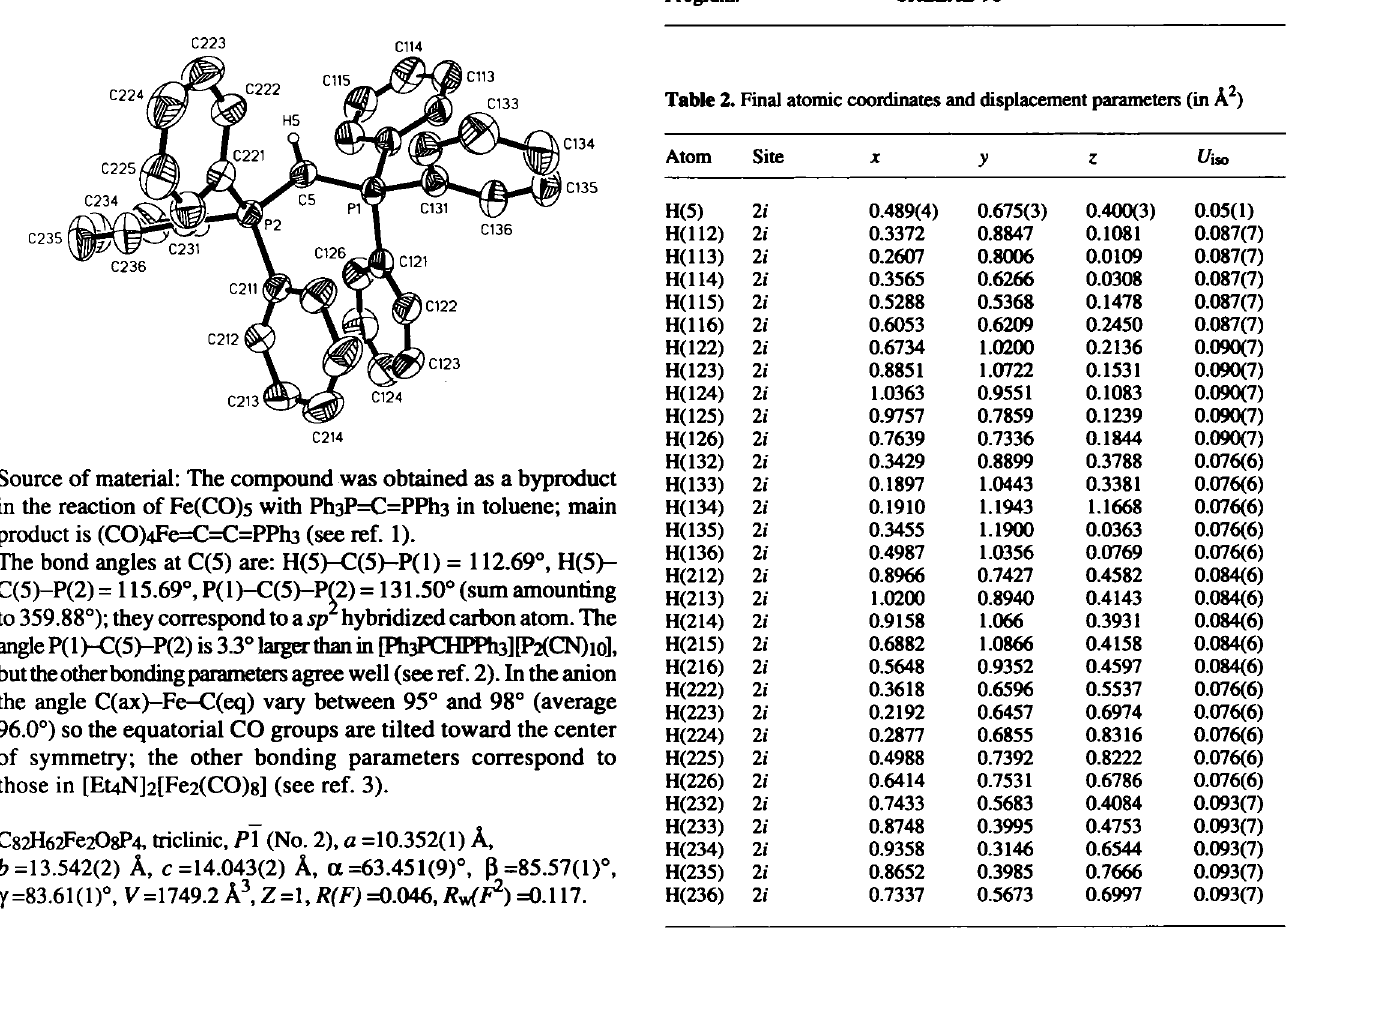
Table 2. Final atomic coordinates and displacement parameters (in À 2